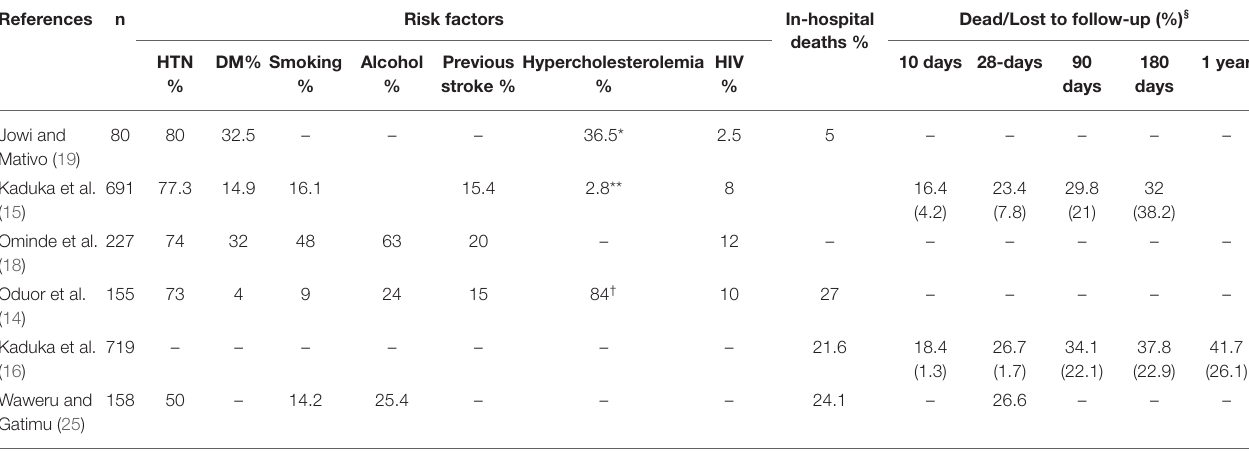
TABLE 2 | Risk factors and outcomes of stroke in